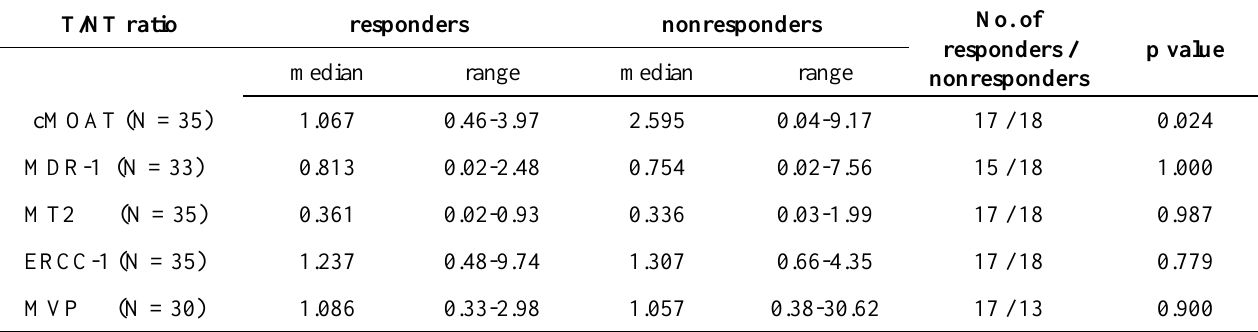
Table 5. Therapeutic effect and T/NT ratio of each resistance factor gene mRNA expression level. T/NT ratio responders nonresponders No. of median range median